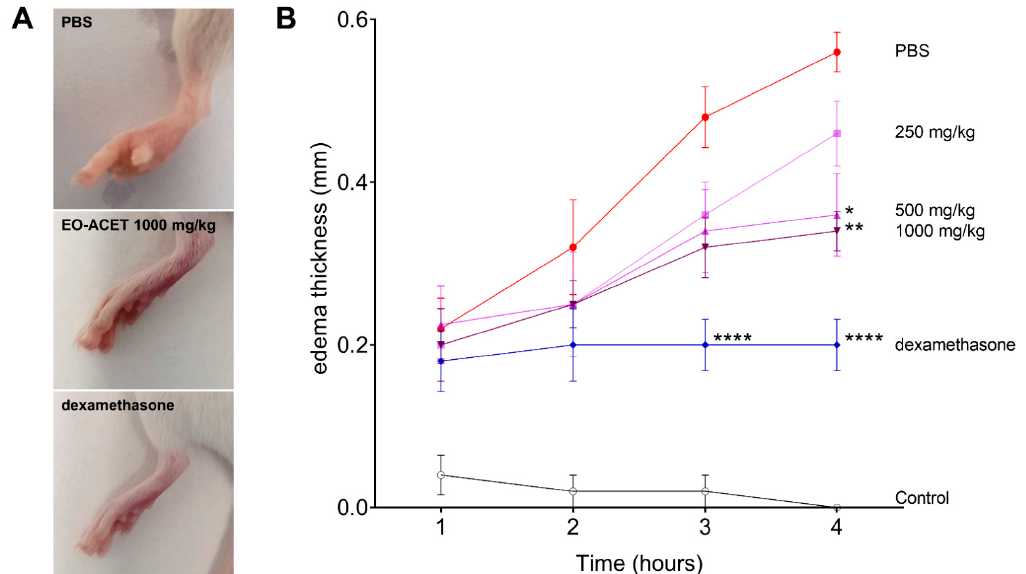
Figure 5. Paw edema of BALB/c mice inoculated with of λ -carrageenan and treated with Euterpe oleraceae ethyl acetate fraction (EO-ACET). Macroscopy ( A ) and kinetic of edema thickness ( B ) of animals inoculated with 25 µL of λ -carrageenan 1% and treated with 100 µL EO-ACET (purple lines) at 250, 500 or 1000 mg/kg by gavage or with dexamethasone (blue line) at 5 mg/kg via the intramuscular route. Data represent the experiment carried out in quintuplicate. * p < 0.05, ** p < 0.01, **** p < 0.0001, when compared with PBS group (red line), after analysis of variance (two-way ANOVA) followed by Bonferroni’s multiple comparisons tests.